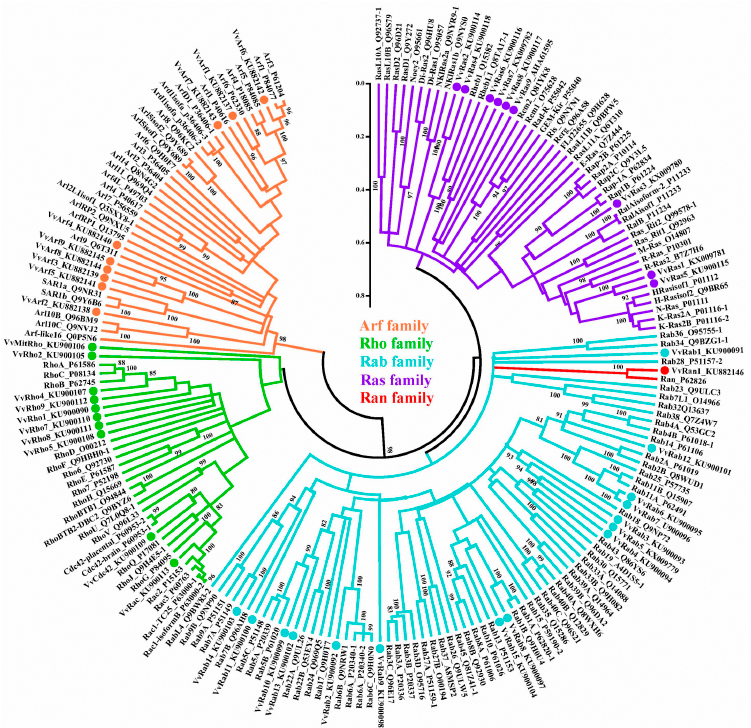
Figure 1. Phylogenetic analysis of human and V. volvacea small GTPases. The 151 human small GTPases were cited based on Rojas et al. [3]. The branches were designated as protein name_uniprot ID. The clades of 44 V. volvacea small GTPases were labeled with the protein name_GenBank ID. The con fi dence levels of nodes were tested by bootstrapping 1000 times; scores ≥ 80% were denoted.